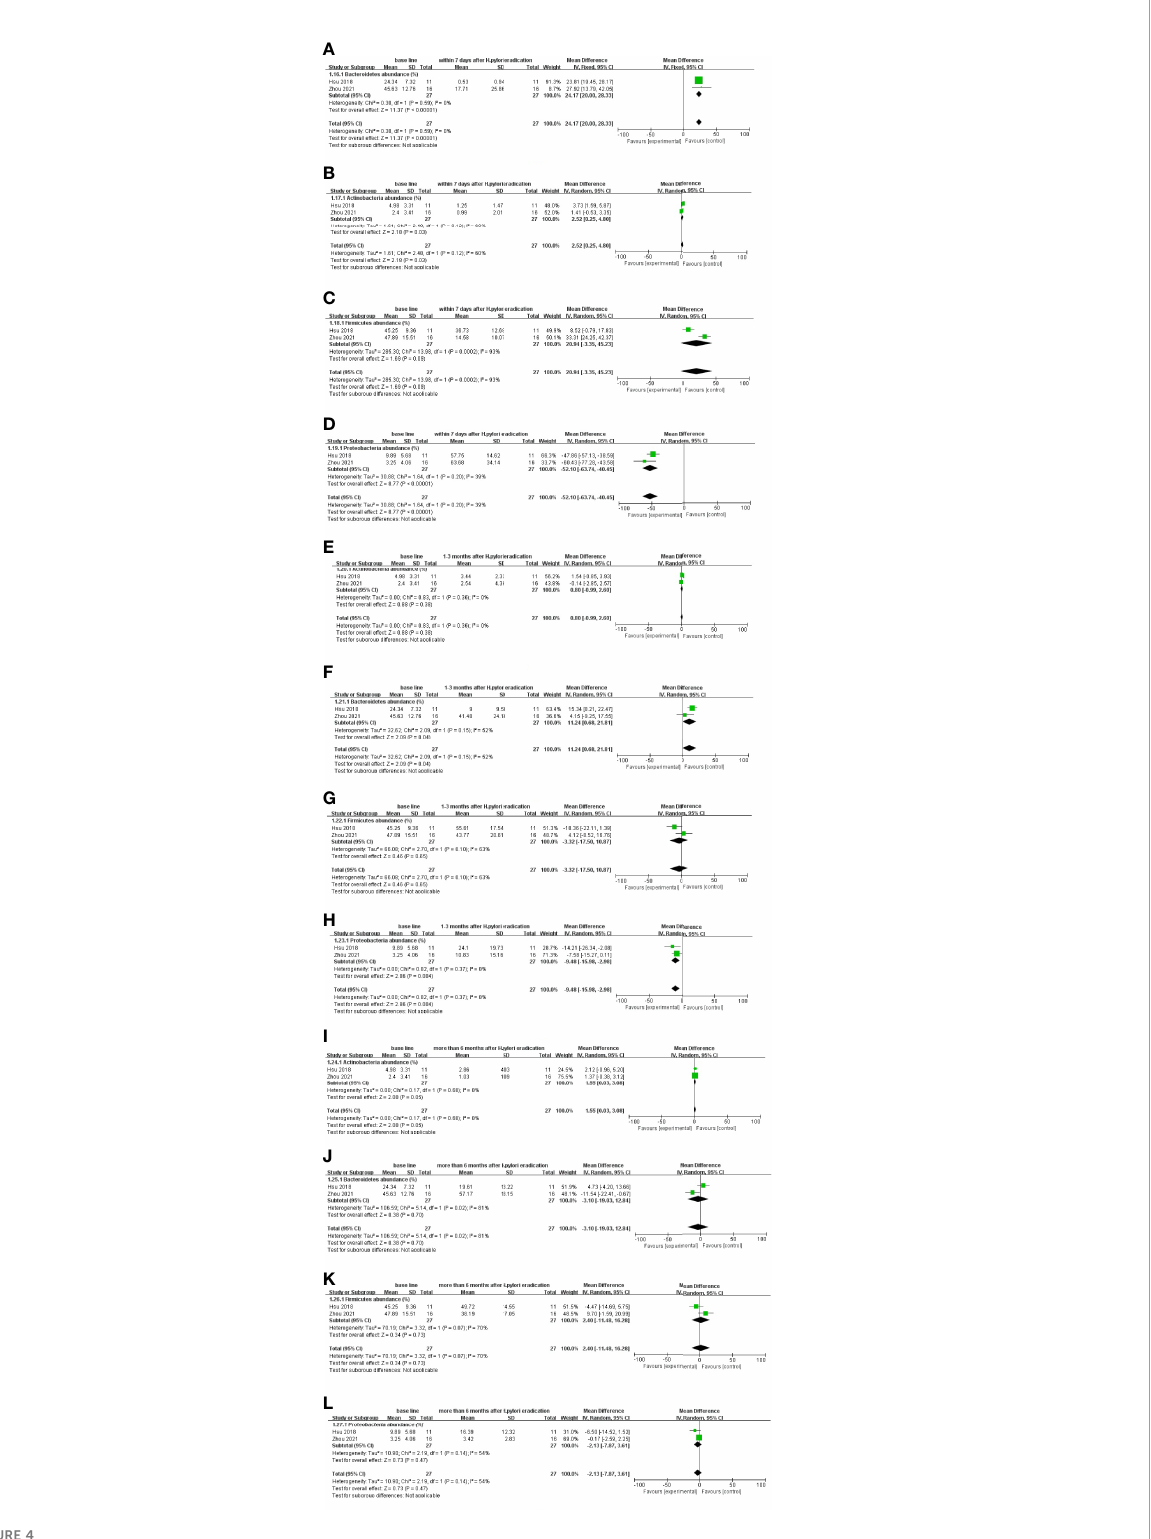
FIGURE 4 Follow-up results after Bismuth-containing quadruple therapy of H. pylori at the phylum level. (A – D) Alterations in gut microbiota within 7 days after eradication treatment follow-up. (E – H) Alterations at 1 – 3 months after eradication treatment follow-up. (I – L) Changes more than 6 months after eradication treatment